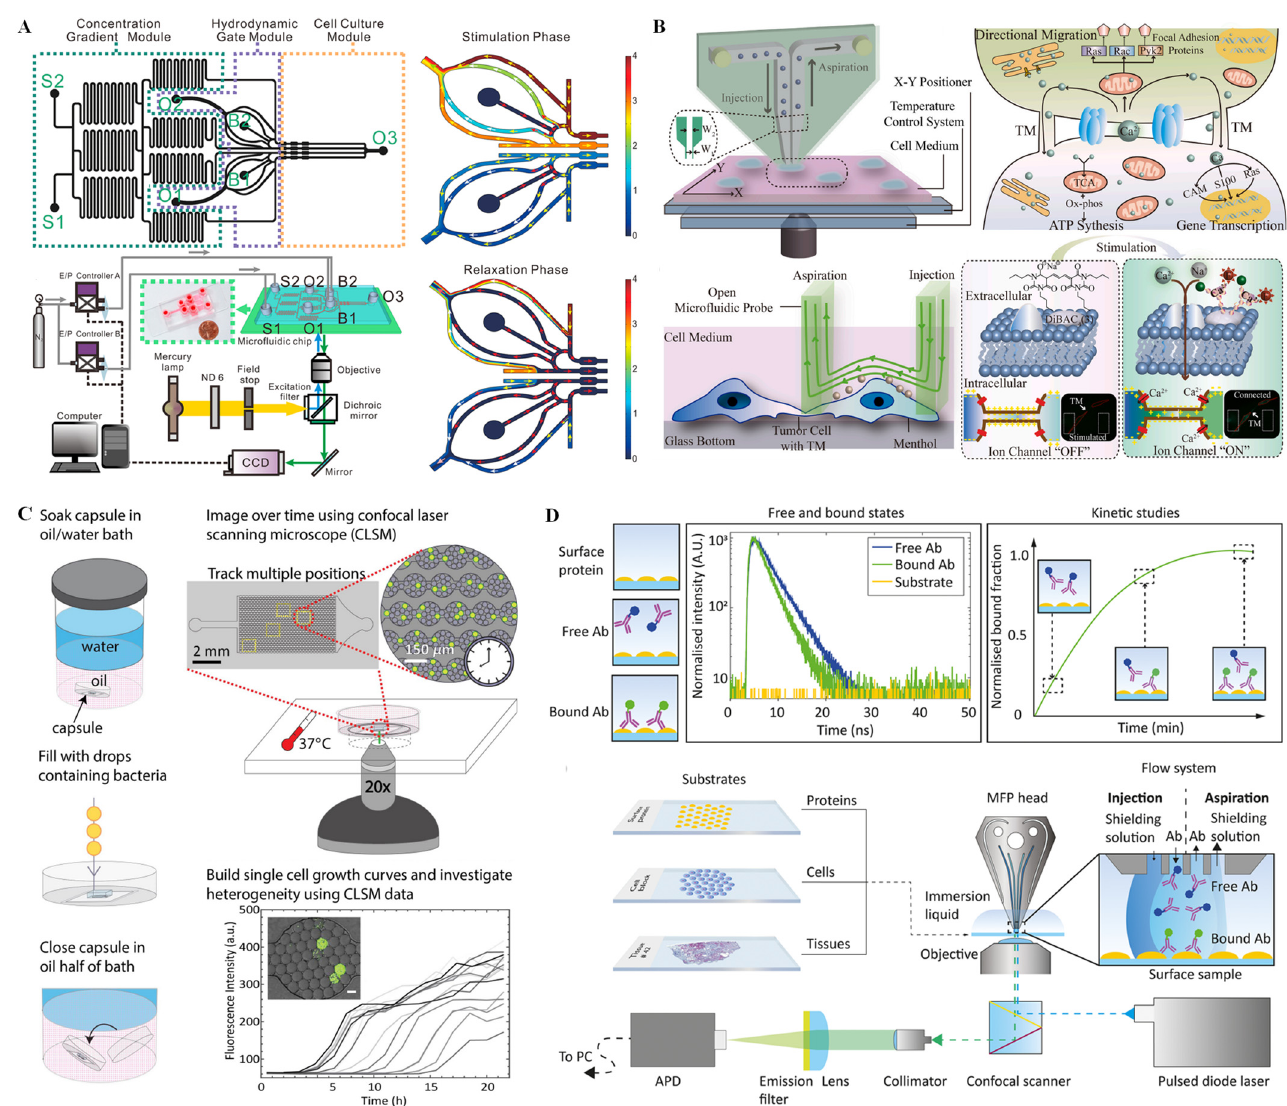
Figure 5. Fluorescence technique for single-cell analysis on microchips . ( A ) Schematic overview of the experimental setup and the microfluidic channel structure for cell dynamic signaling through a stimulation phase and relaxation phase. Reprinted with permission from ref. [64], Copyright 2020 American Chemical Society. ( B ) Schematic diagram describing cell culture, calcium signaling, single-cell stimulation, signal transmission, and communication on the microfluidic platform. Reprinted with permission from ref. [65], Copyright 2022, Elsevier B. V. ( C ) Schematic overview of drop stabilization on the chip and physiological study of single microbial cells by CLSM. Reprinted with permission from ref. [67], Copyright 2019 Pratt, Zath, Akiyama, Williamson, Franklin and Chang. ( D ) Overview of the antibody kinetic analysis procedure by variable fluorescence decay time monitoring on a microfluidic chip integrated with a confocal scanner microscope. Reprinted with permission from ref. [69], Copyright 2022 American Chemical Society.